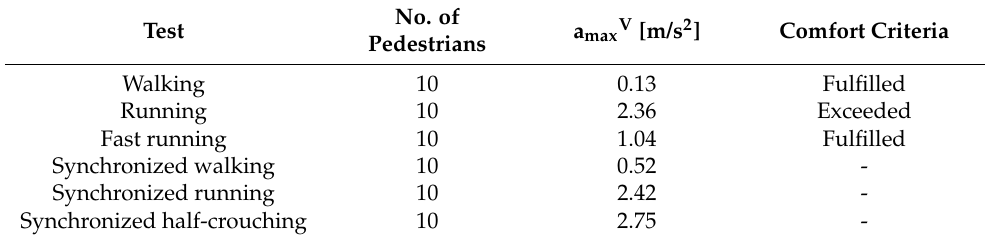
Figure 24. Modal shapes: f 1H = 1.31 Hz, f 2H = 3.51 Hz (horizontal) and f 1V = 2.96 Hz, f 2V = 9.10 Hz (vertical) [32]. Table 6. Values of extreme accelerations of the deck.